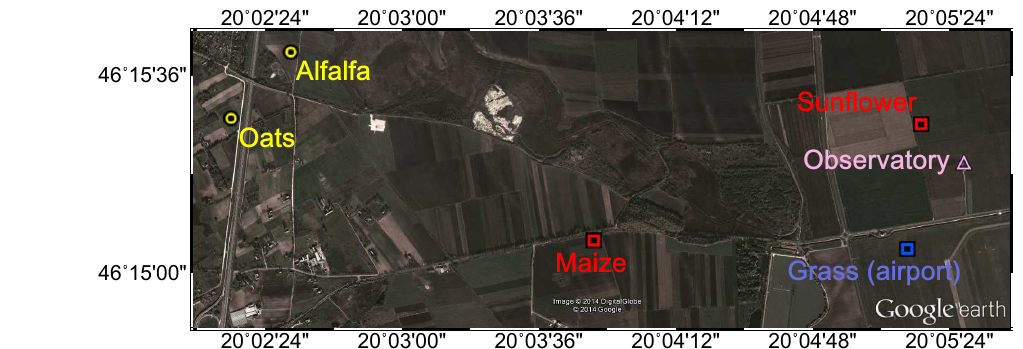
Figure 1. Location of the upper air observatory and the soil measurement sites.